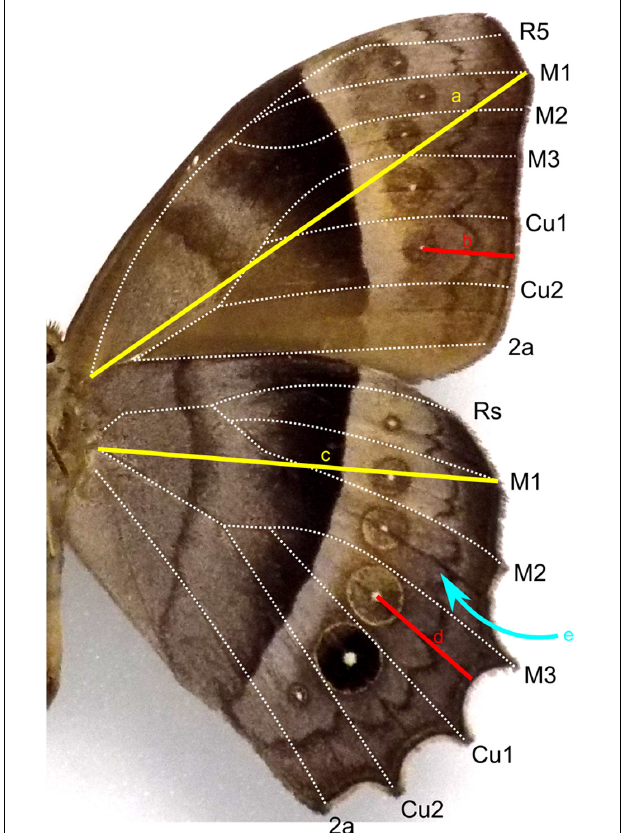
FIGURE 2 | Diagram of wing measurements on a general Nymphalid wing surface. Wing length was measured as the distance from the base of the wing to the distal tip of the M1 vein for forewing (a) and hindwing (c) . Placement of an ocellus was measured as the distance from the focus to the wing margin (b,d) . A straight line was drawn following the groove along the midline (e) of each wing cell.